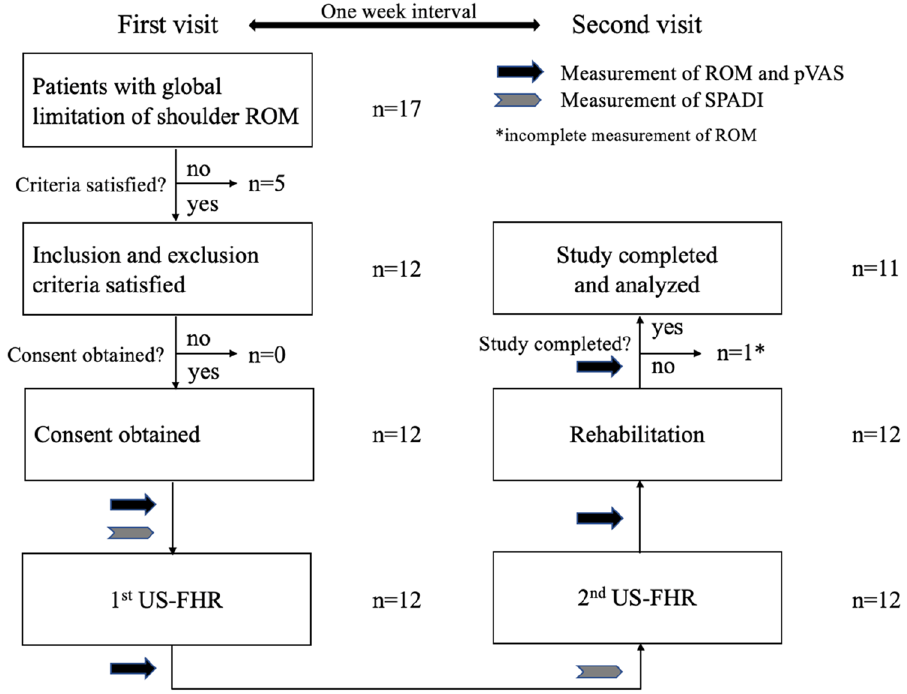
Figure 3. Flowchart showing patient selection and treatment. The patient’s flow was as follows: on the first visit to the clinic, the patients underwent initial assessment, informed consent process, and 1st US-FHR consecutively. On the second visit, the patients underwent 2nd US-FHR and then rehabilitation. We recruited 17 patients with global limitation of shoulder ROM. 12 of them met the inclusion and exclusion criteria. After informed consent of the study was obtained, all of the 12 underwent 1st US-FHR on the first visit, 2nd US-FHR and rehabilitation on the second visit that is scheduled approximately one week from the 1st. 11 completed the study protocol, while one did not complete the measurement and dropped out from the analysis. The black arrow indicates the time point of measuring ROM and pVAS. The gray arrowhead indicates the time point of measuring SPADI. Abbreviations: ROM, passive range of motion; SPADI, shoulder pain and disability index; US-FHR, ultrasound-guided fascia